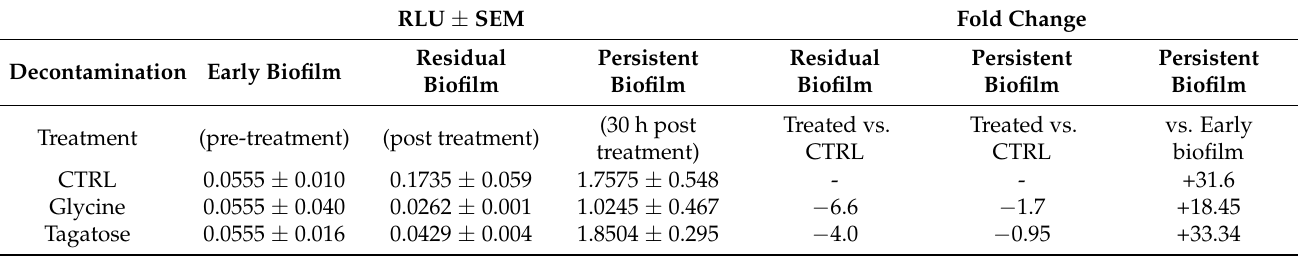
Table 1. Evaluation of cleaning efficacy of the two polishing powders. Effects of the decontamination procedure on the formation and persistence of microbial biofilm onto titanium disks after air-polishing cleansing with glycine and tagatose. Control group (CTRL) consisting in titanium surfaces washed with saline solution. The values are express as RLU and represent the mean ± SEM of 5 replicates (* p < 0.05, GLY vs. CTRL and TAGAT vs. CTRL, when evaluating residual biofilm).